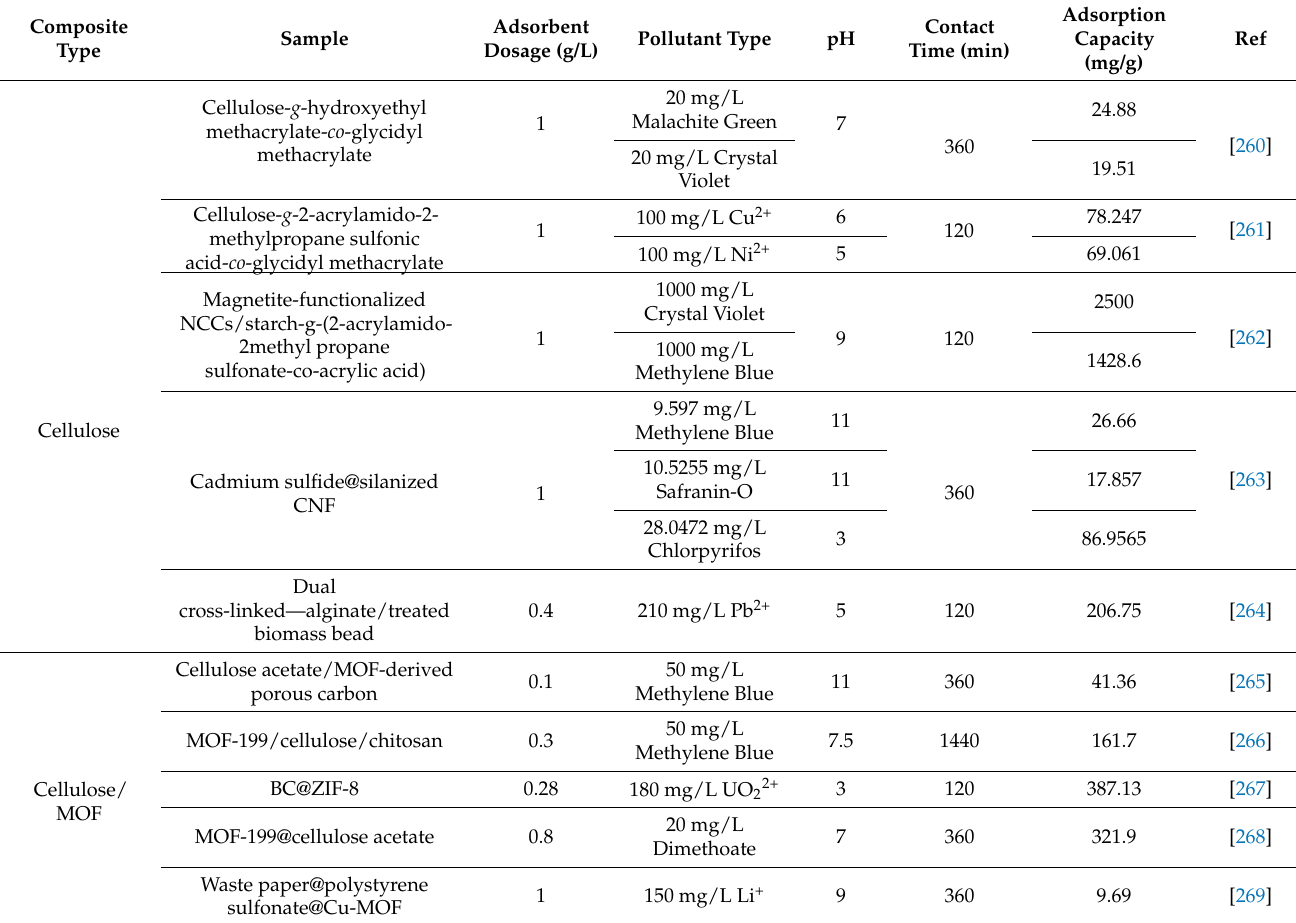
Table 5. Performance of cellulose and cellulose/MOF adsorbents on the removal of pollutants.